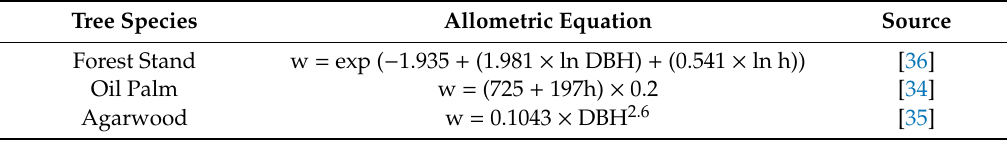
Table 1. Allometric equations used for tree aboveground biomass